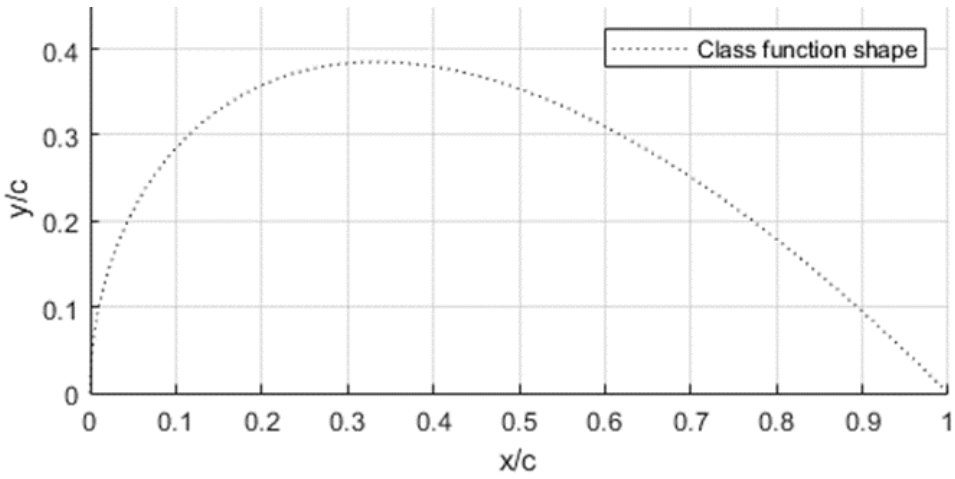
Figure 3. Class function shape with N 1 = 0.5 and N 2 = 1.